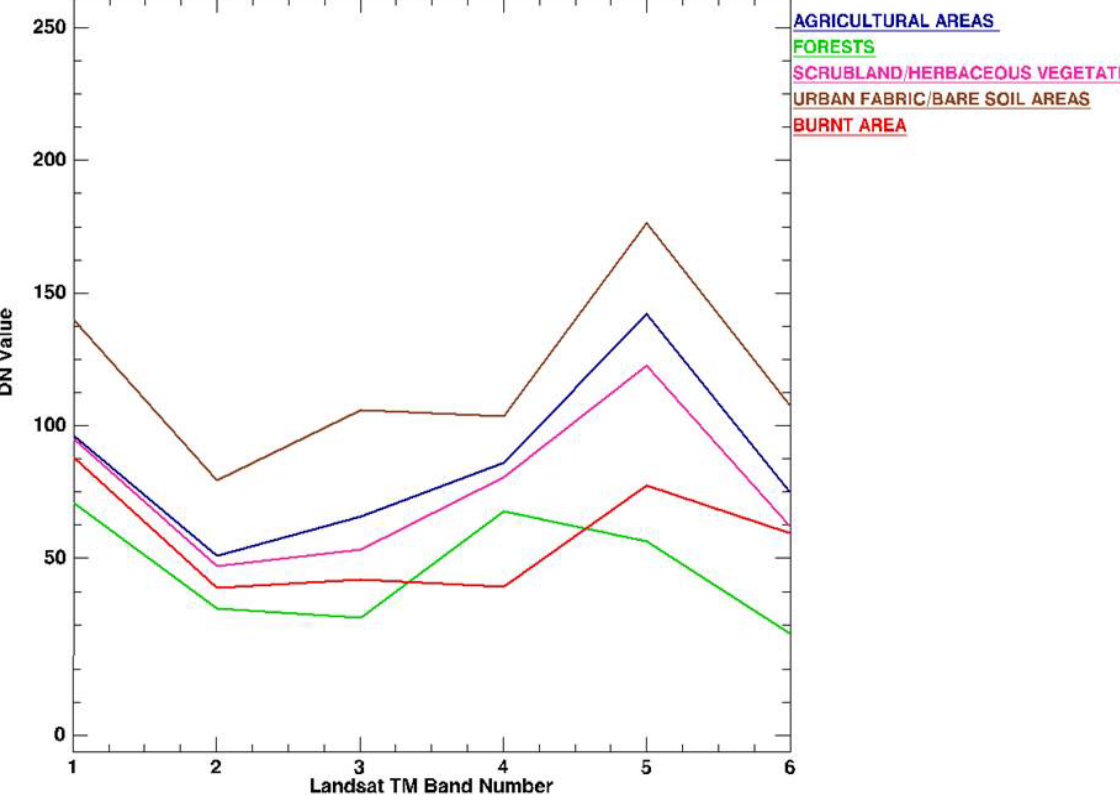
Figure 3. Average spectral signatures based on the selection of pixels selected for implementation of the SAM and ANN in the present study. DN is the pixels’ Digital Number recorded by the Landsat TM imagery which was used in the